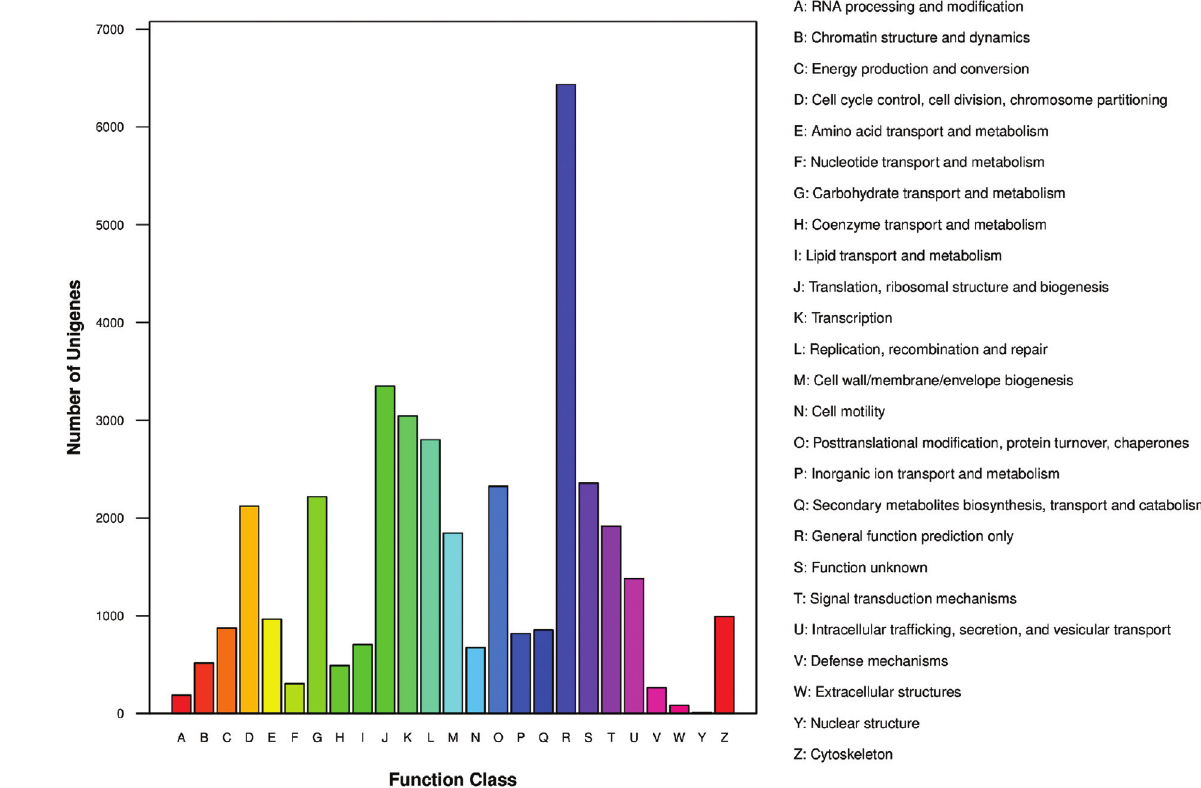
Figure 2 - Cluster of orthologous groups (COG) classification of putative